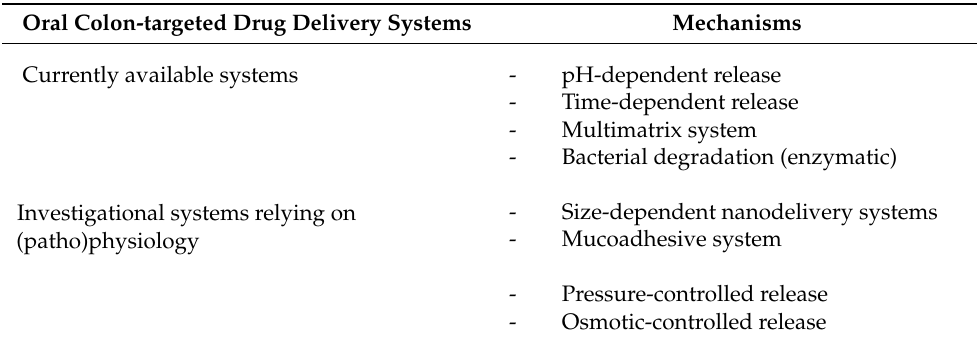
Table 1. Schematic overview of oral colon-targeted drug delivery